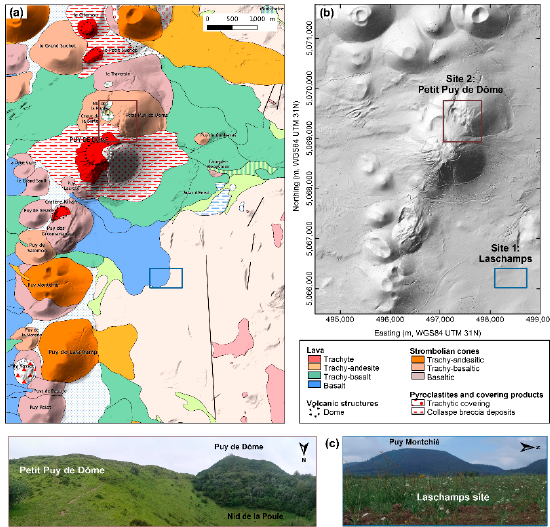
Figure 1. Location of the two field sites in the center-east part of the Chaîne des Puys (French Massif Central) on ( a ) the volcanological map [13] and ( b ) the DTM generated from the Lidar survey performed in 2015 (precision of 0.5 m). ( c ) Field views of both test sites.